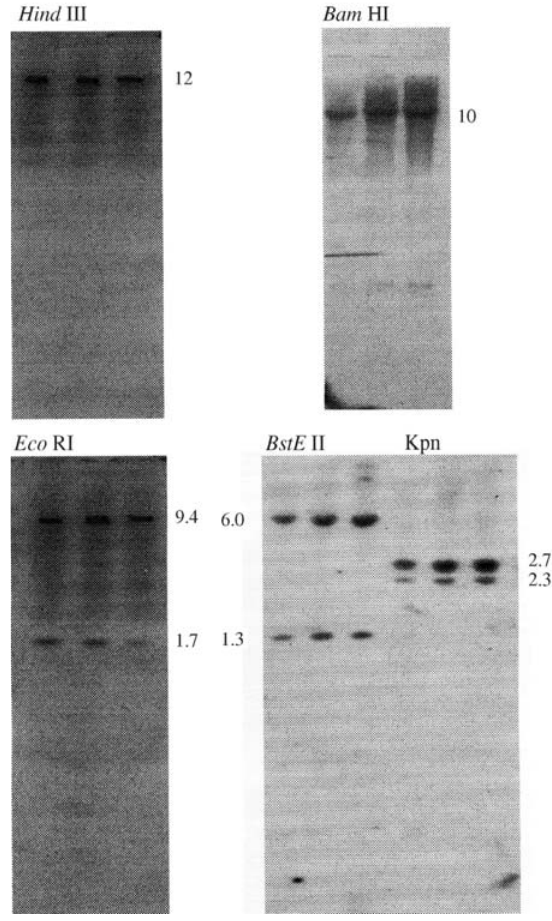
Figure 4 - Southern blot analysis of genomic buffalo DNA digested with restriction endonucleases. The samples were of phenotype BB that con- tained different Hb2:Hb4 ratios (approx. 55:45, 65:35 and 75:25). The fragment sizes are given in kb.